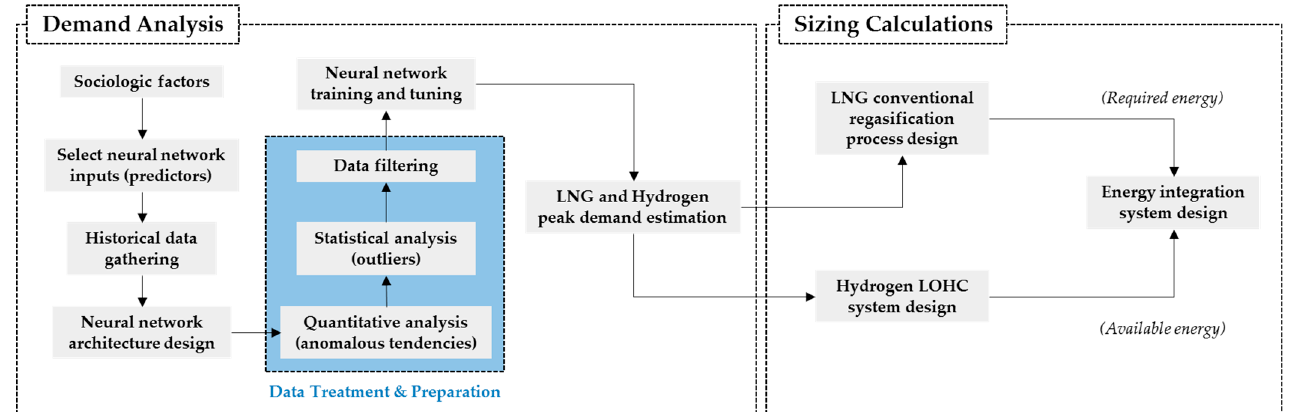
Figure 2. Block diagram of the methodology and calculations.